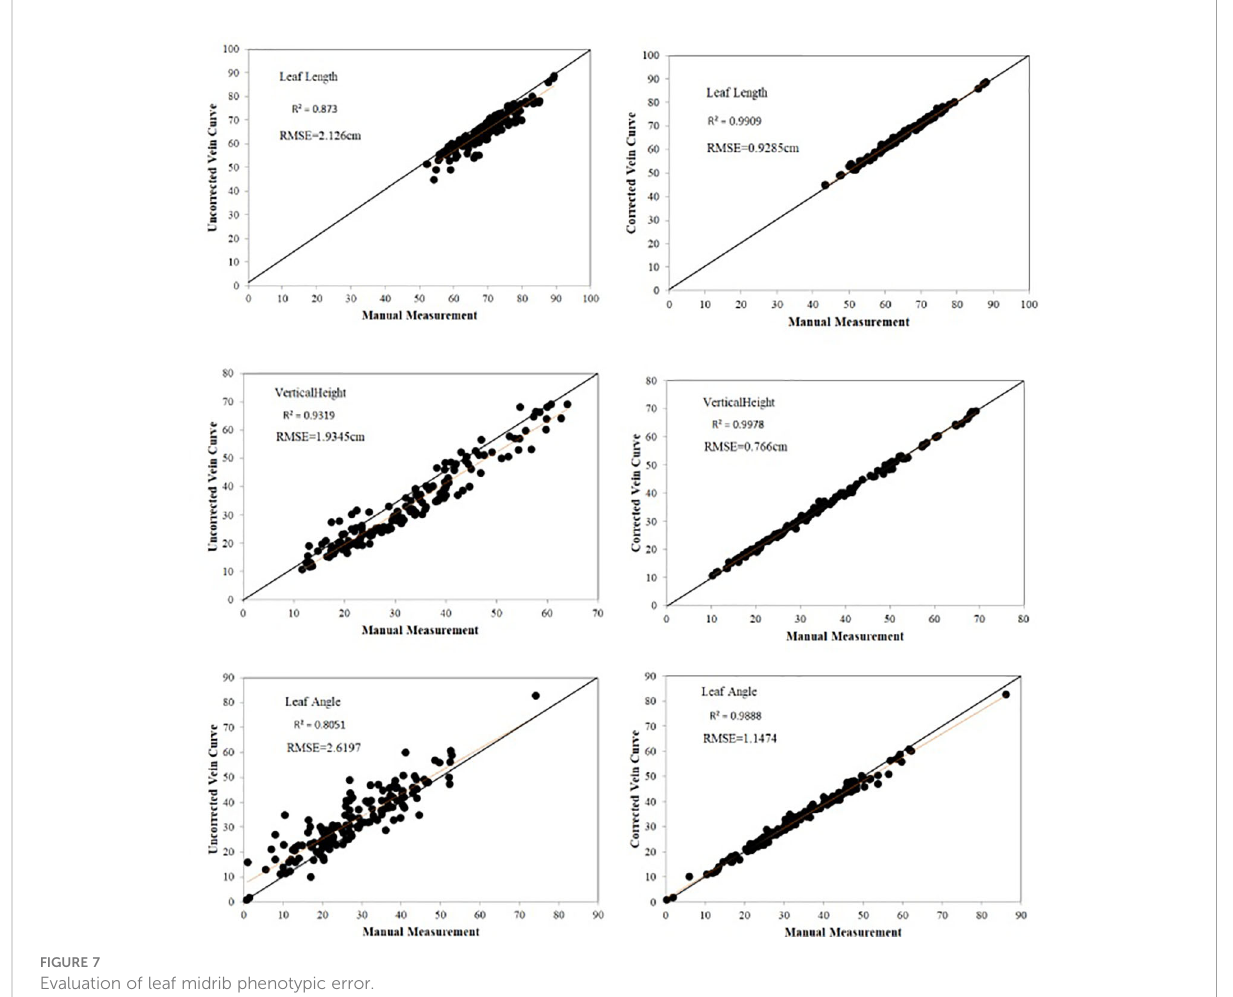
FIGURE 7 Evaluation of leaf midrib phenotypic error.